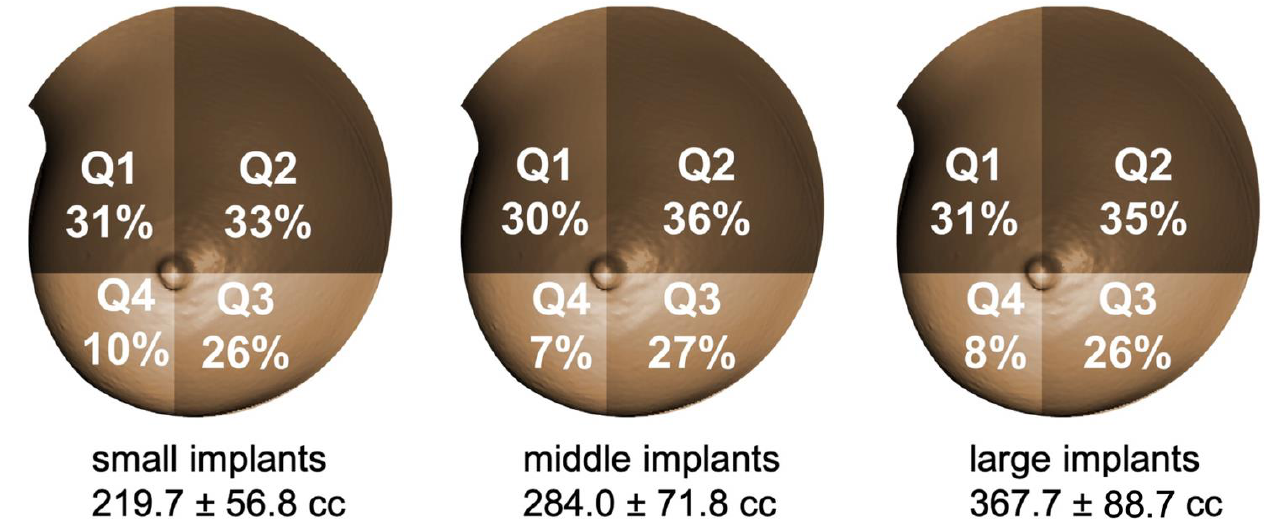
Figure 6. Percentual distribution of TS among quadrants with different implant sizes. Q1= superolateral, Q2 = superomedial, Q3 = inferomedial and Q4 = inferolateral breast quadrant. Comparable topographic breast quadrant changes were found in all implant sizes and shapes. More than 60% of TS was in the upper quadrants for both anatomical and round implants of each size.